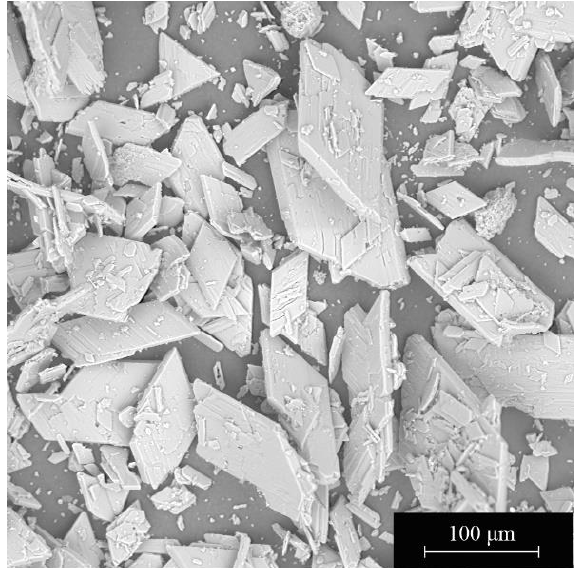
Figure 3. SEM image of the PG.